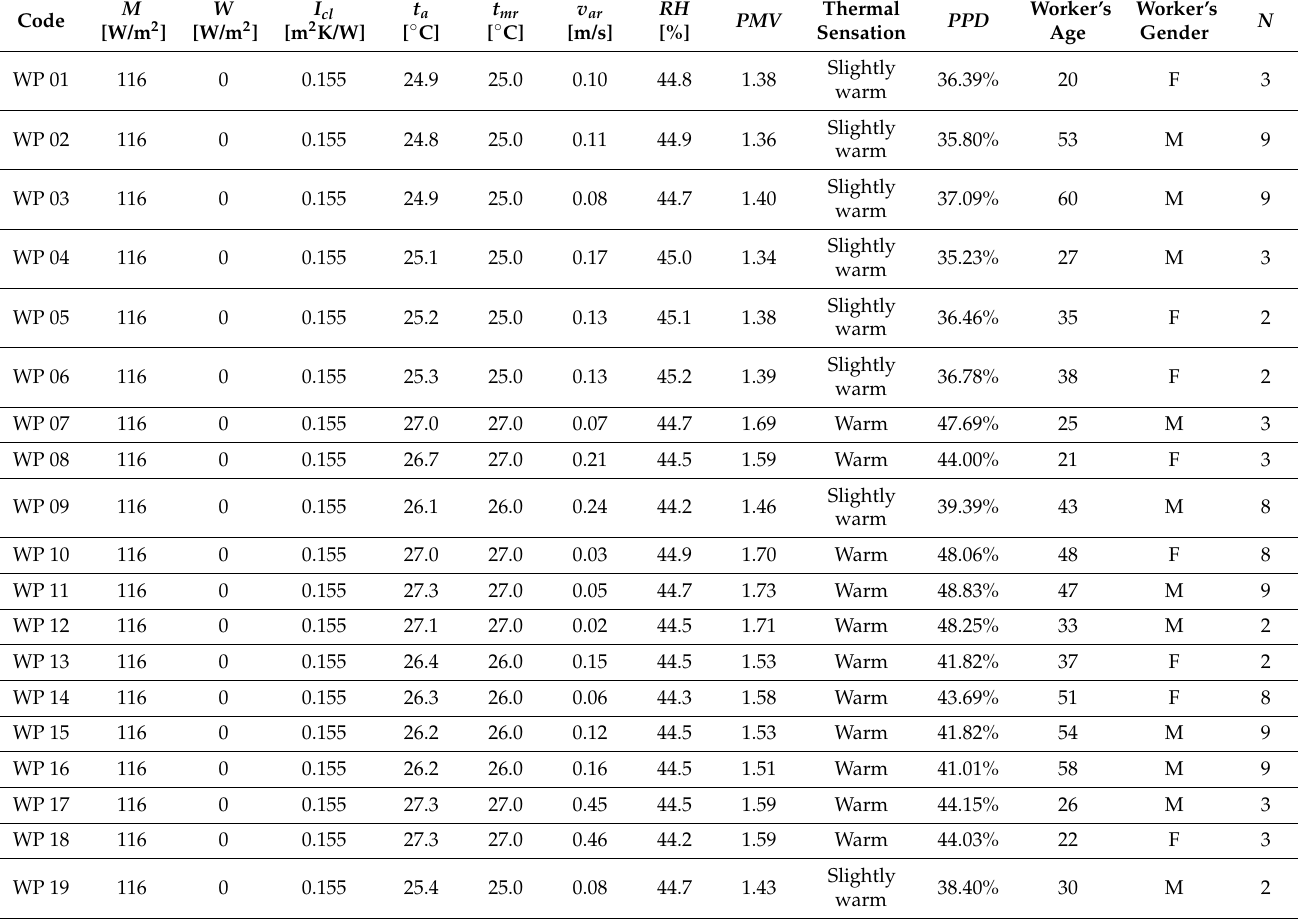
Table 4. Measurement results and collected